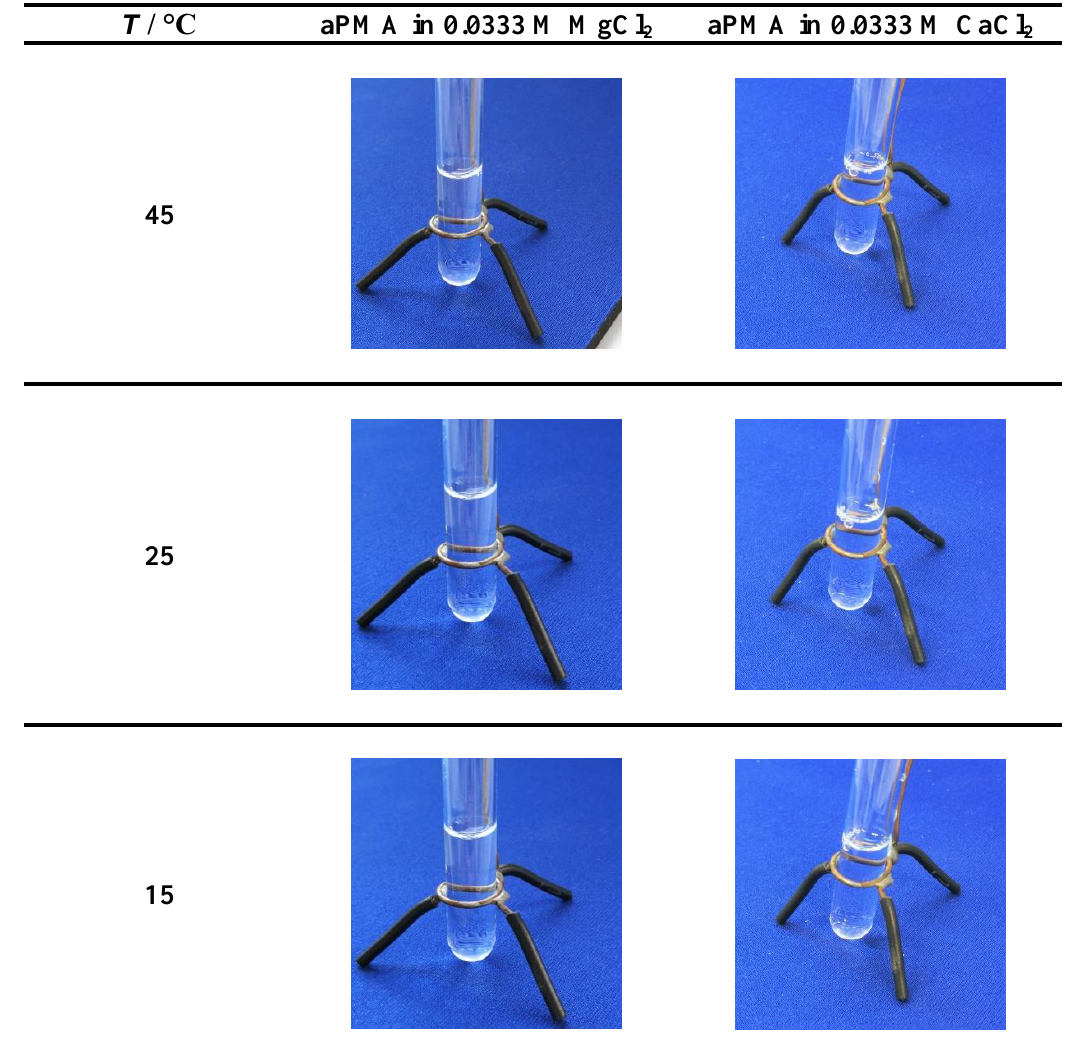
= 0.022 mol L -1 , α p